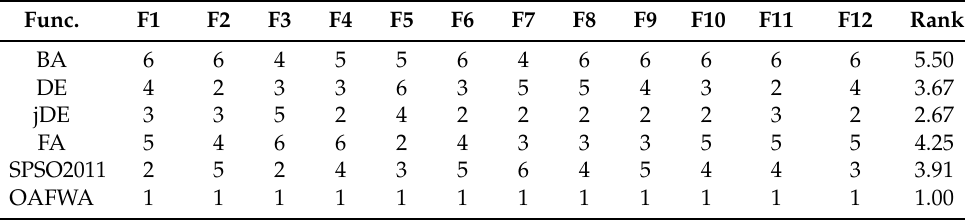
Table 12. Ranks for the six algorithms when popSize = 40.